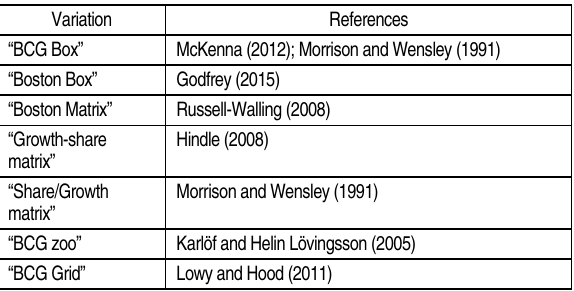
Table 2. Variations of the BCG Matrix